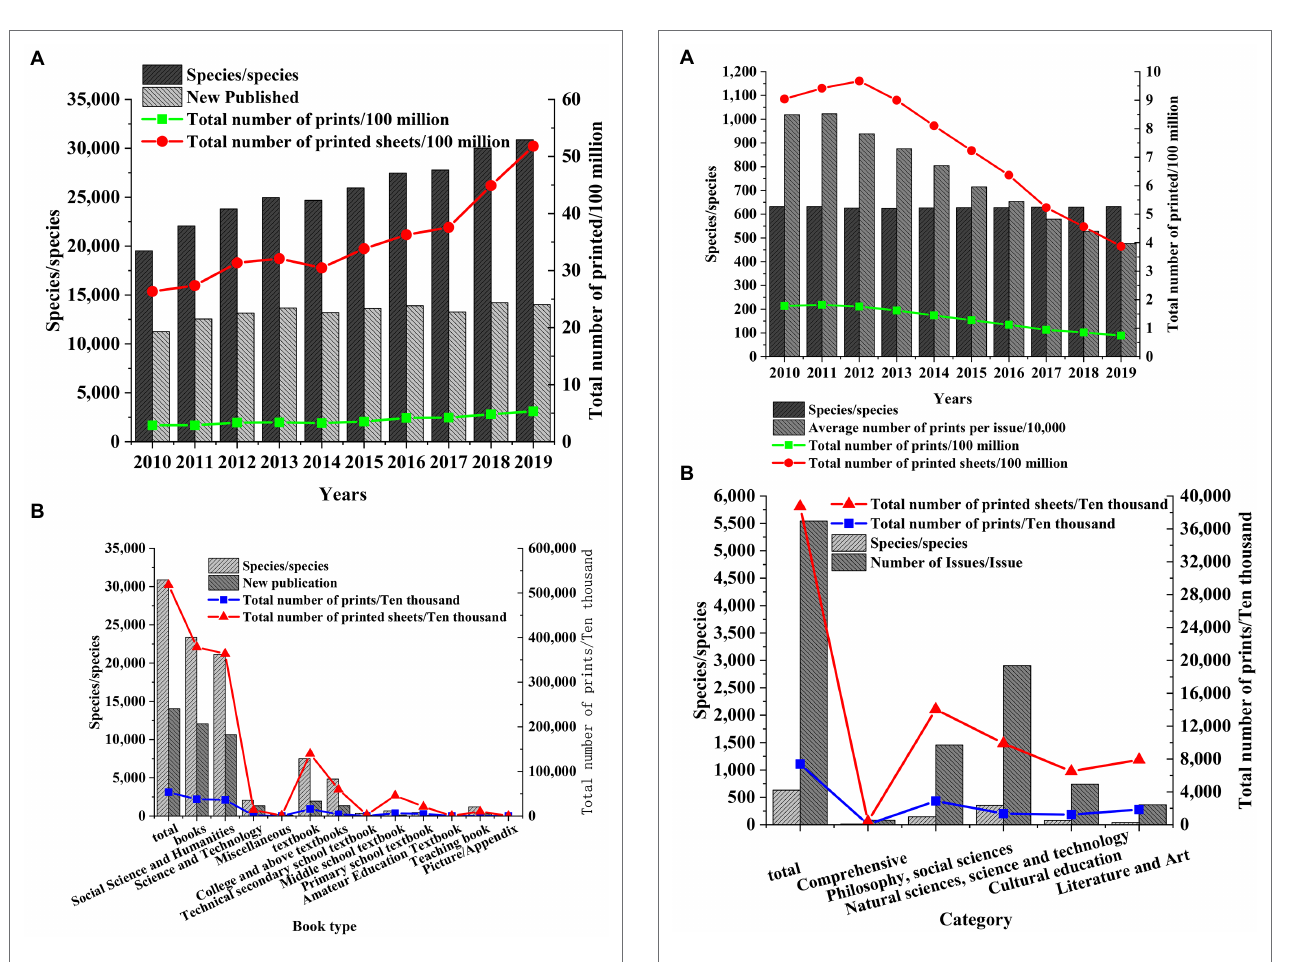
FIGURE 2 | Number of books published in Shanghai. (A) Number of books published in Shanghai in 2010. (B) Types of books published in Shanghai in